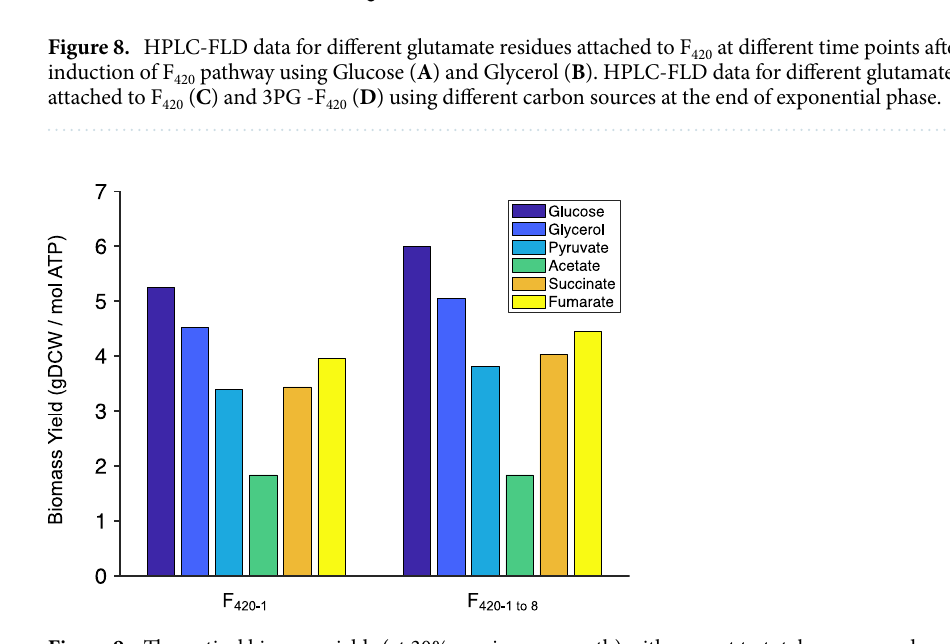
Figure 9. Theoretical biomass yields (at 30% maximum growth) with respect to total energy produced in the form of ATP predicted by the iEco-F420 metabolic model of E. coli BL21 simulated with different carbon sources. F 420 -1 indicates the yields for cells synthesizing cofactor F 420 with only one glutamate tail, whereas F 420 -1 to 8 indicate those for cells synthesizing a mixture of F 420 molecules with varying number of glutamate tails. The uptake of C-source was fixed to 60 C-mol in all simulations to account for differences in number of carbon atoms in